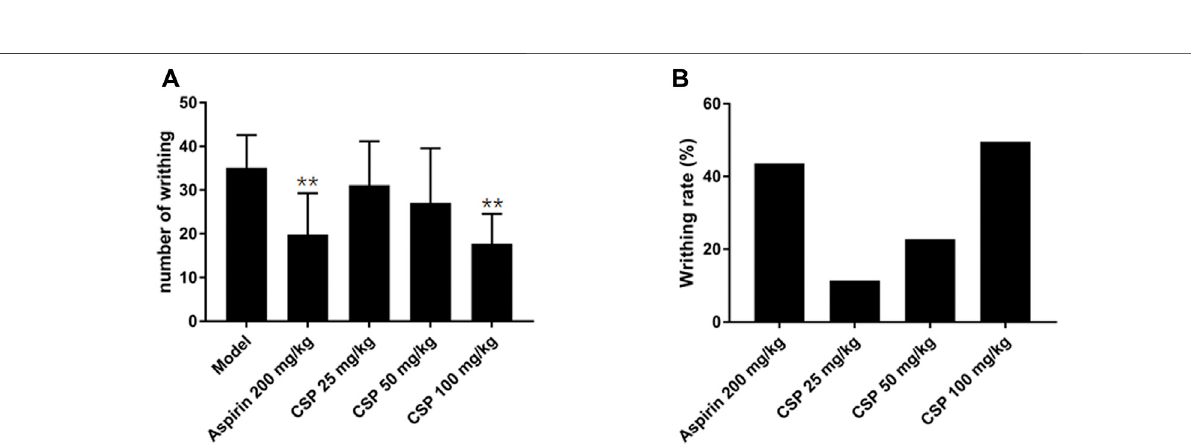
FIGURE5| Effects ofCSP on pro-in fl ammatory cytokine expression intheserum ofCFA mice.Thecytokines IL-1 β (A) ,TNF- α (B) ,and COX-2 (C) weremeasured by ELISA. The data are presented as the mean ± SEM ( n = 5). * p < 0.05; ** p < 0.01 vs. the CFA model group.